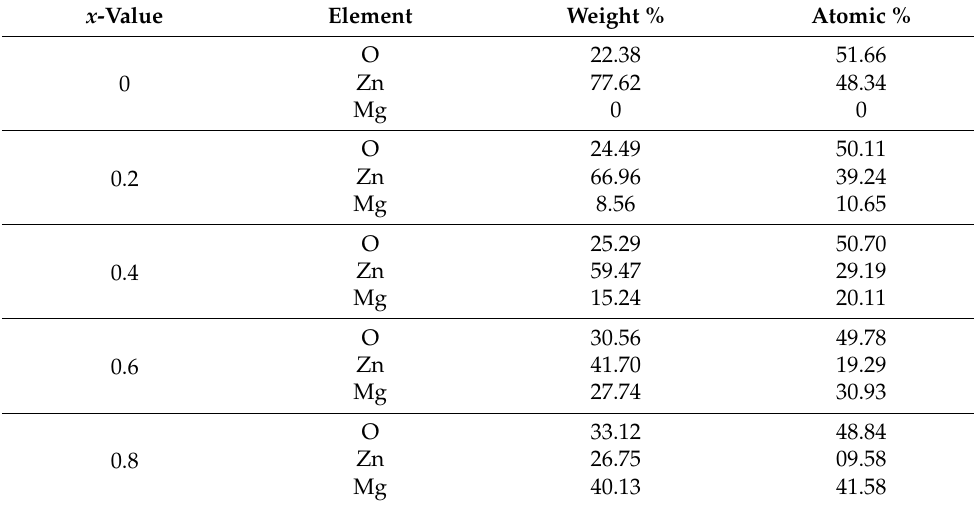
Table 1. Chemical composition, according to the EDX-analysis, of the Zn 1 − x Mg x O alloy films depos- ited by spin coating.